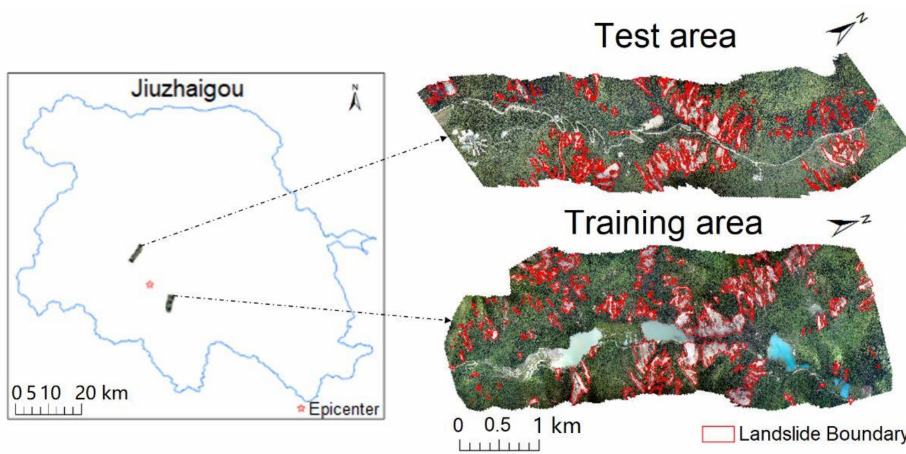
Figure 8. Location of training area and test area.